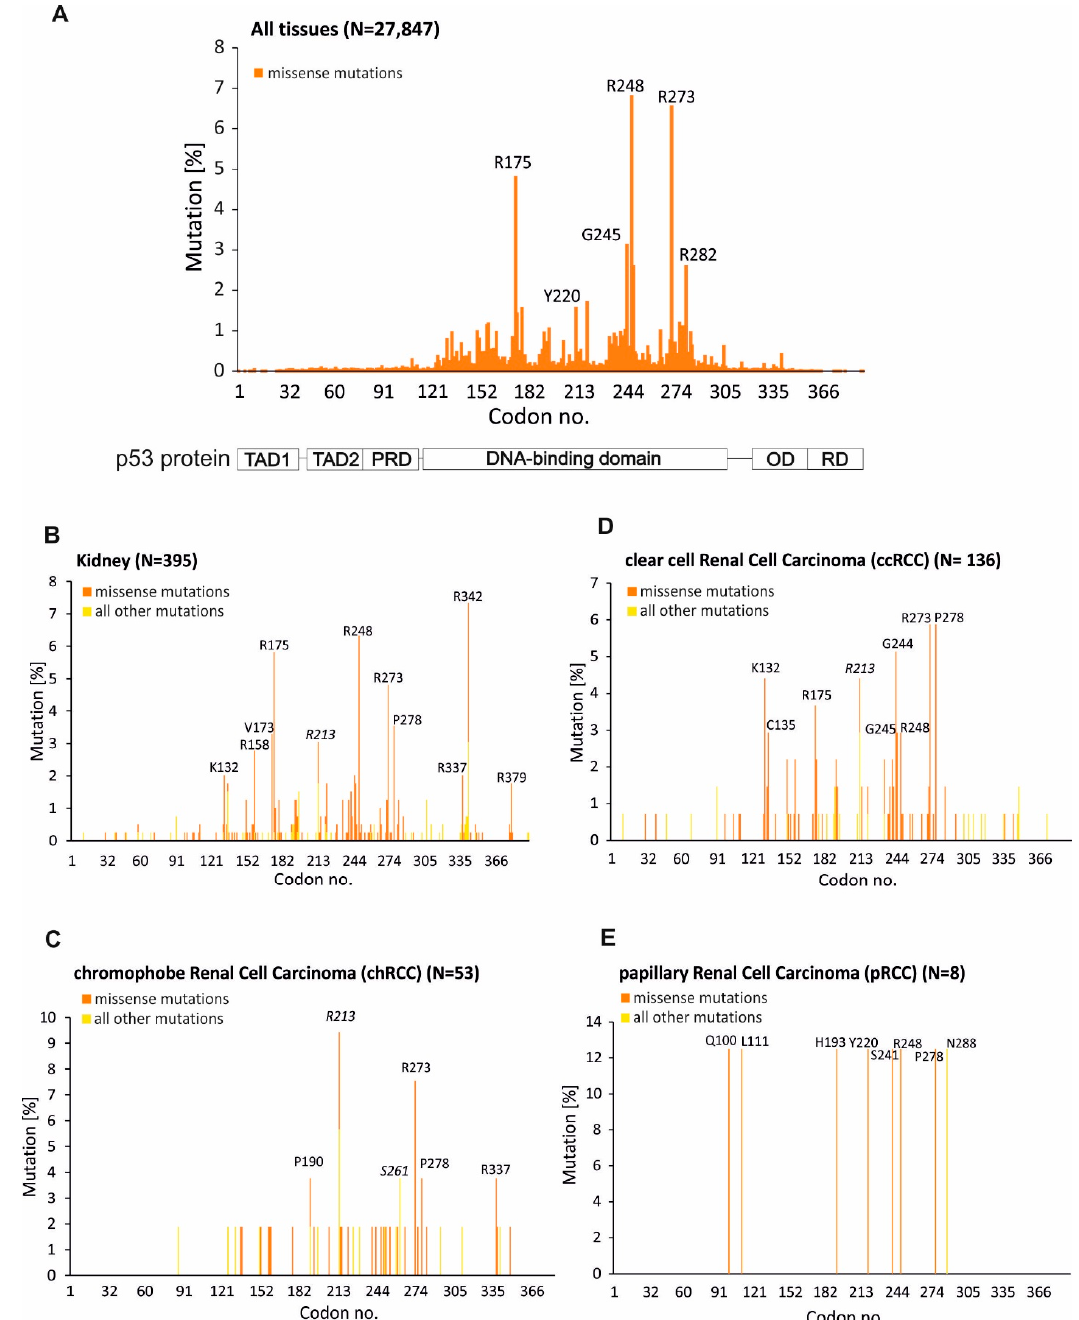
Figure 3. A graphical view of mutations across Tp53 gene in all tissues ( A ), kidney ( B ), chromophobe renal cell carcinoma ( C ), clear cell renal cell carcinoma ( D ), and papillary renal cell carcinoma ( E ). The mutations are displayed at the amino acid level across the full-length of the gene. A schematic representation of the domains of p53 protein: TAD1 and TAD2—transactivation domains 1 and 2, PRD—proline rich domain, DNA-binding domain, OD—oligomerization domain, RD—regulatory domain (below graph 3A). Orange color indicates missense mutations whereas yellow color indicates all other mutations including nonsense mutations, frameshifts and deletions. N—total mutated samples taken for analysis (see Table 1). Data are derived from the TP53 database (graph 3A) (https://tp53.isb-cgc.org/) and the COSMIC database (graphs 3B–E).